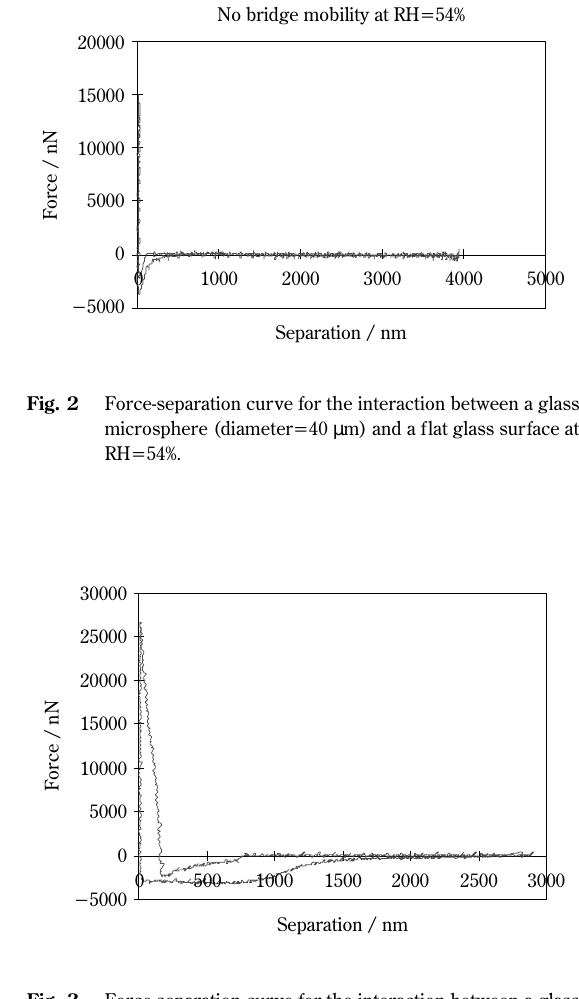
Fig. 3 Force-separation curve for the interaction between a glass microsphere (diameter (cid:2) 30 µ m) and a flat glass surface at RH (cid:2) 83%. Bridge elongation is characterised by the extended separation distance in the retraction curve, (lower